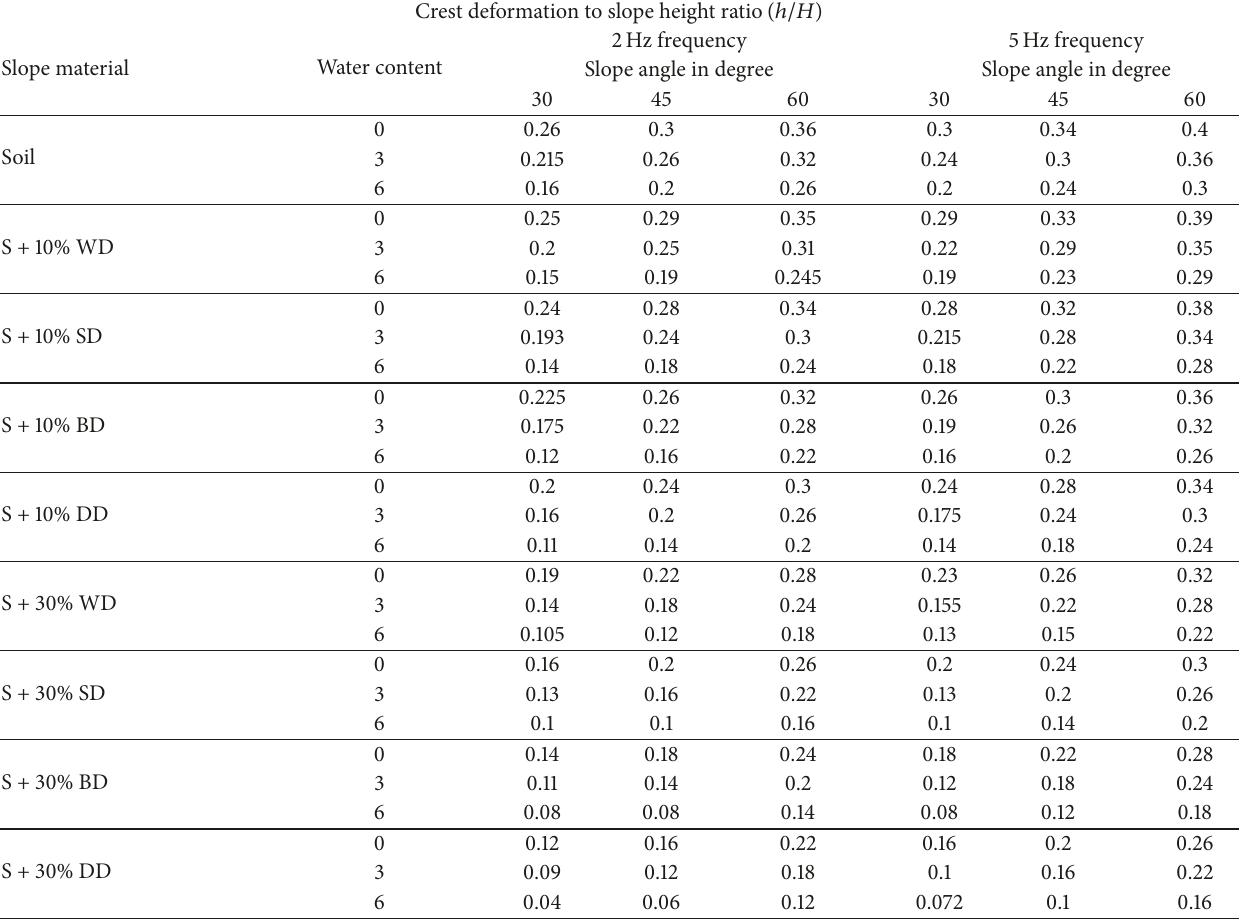
Table 5: Response of slope made up of soil and soil dust mixtures in terms of crest deformation at frequency of input motion 2 Hz and 5Hz. Crest deformation to slope height ratio (ℎ/𝐻) Slope material